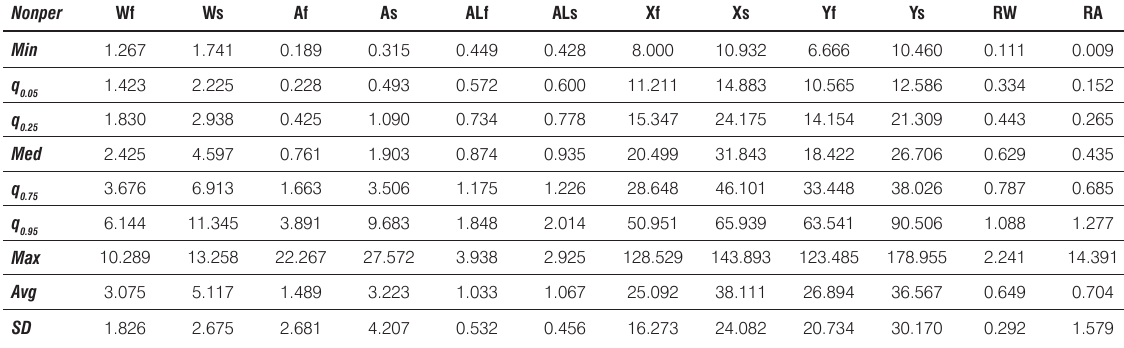
Table 4. Data distribution of observed parameters in patients with central nervous system vestibular dysfunction.